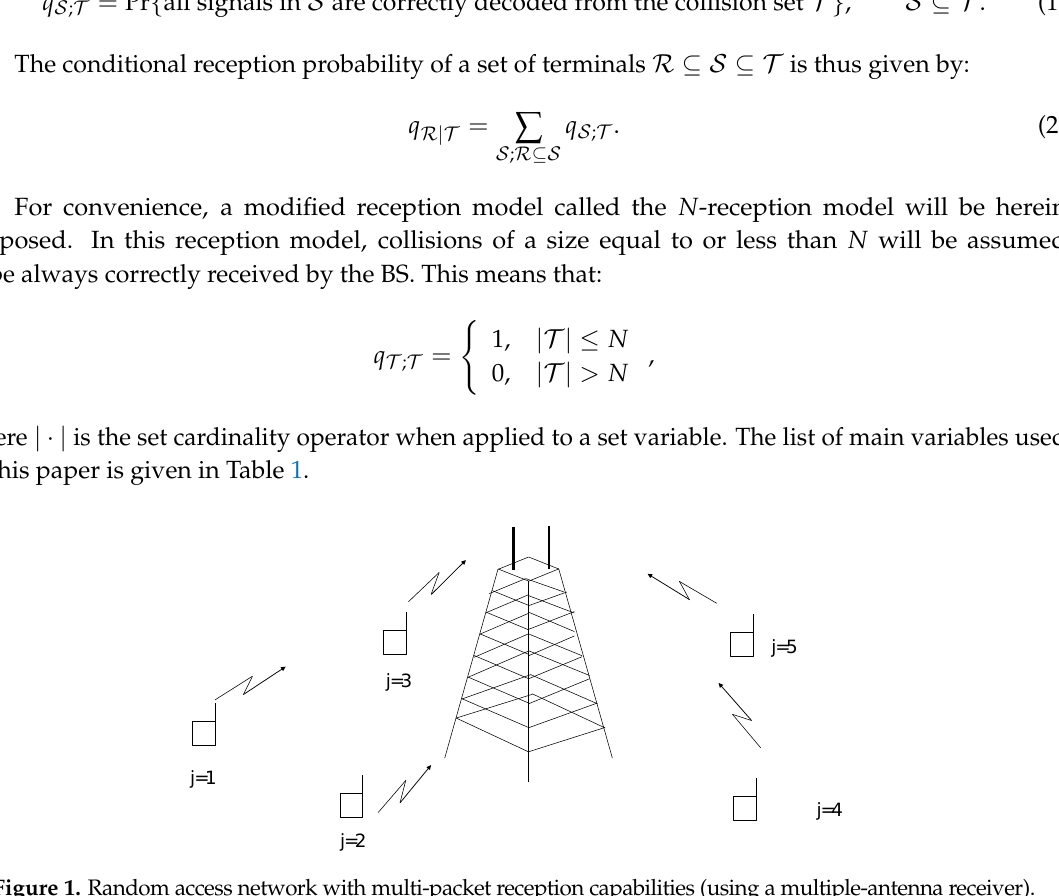
Figure 1. Random access network with multi-packet reception capabilities (using a multiple-antenna